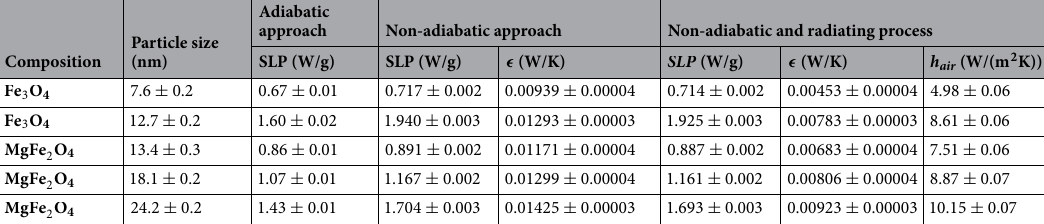
Table 1. Summary of our findings. The average particle size is estimated by TEM. The experimental thermal quantities for our magnetite and magnesium ferrite nanoparticles are estimated by fitting, using the theoretical approaches, from magnetic hyperthermia experiments performed with alternating magnetic field with frequency of 70.5 kHz and amplitude of 70 Oe. Specifically, we estimate SLP and ǫ , and consequently h air from Eq. (20), from our approach describing magnetic nanoparticles under AMF in a non-adiabatic and radiating process, as well as, for comparison, the SLP from the adiabatic model, and SLP and ǫ from the approach considering non-adiabatic